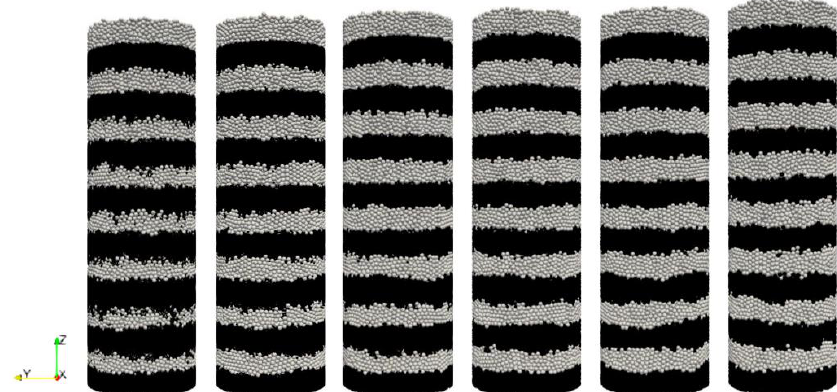
Figure 18. Stock columns with different particle size ratios (gray: coke; black: sinter).